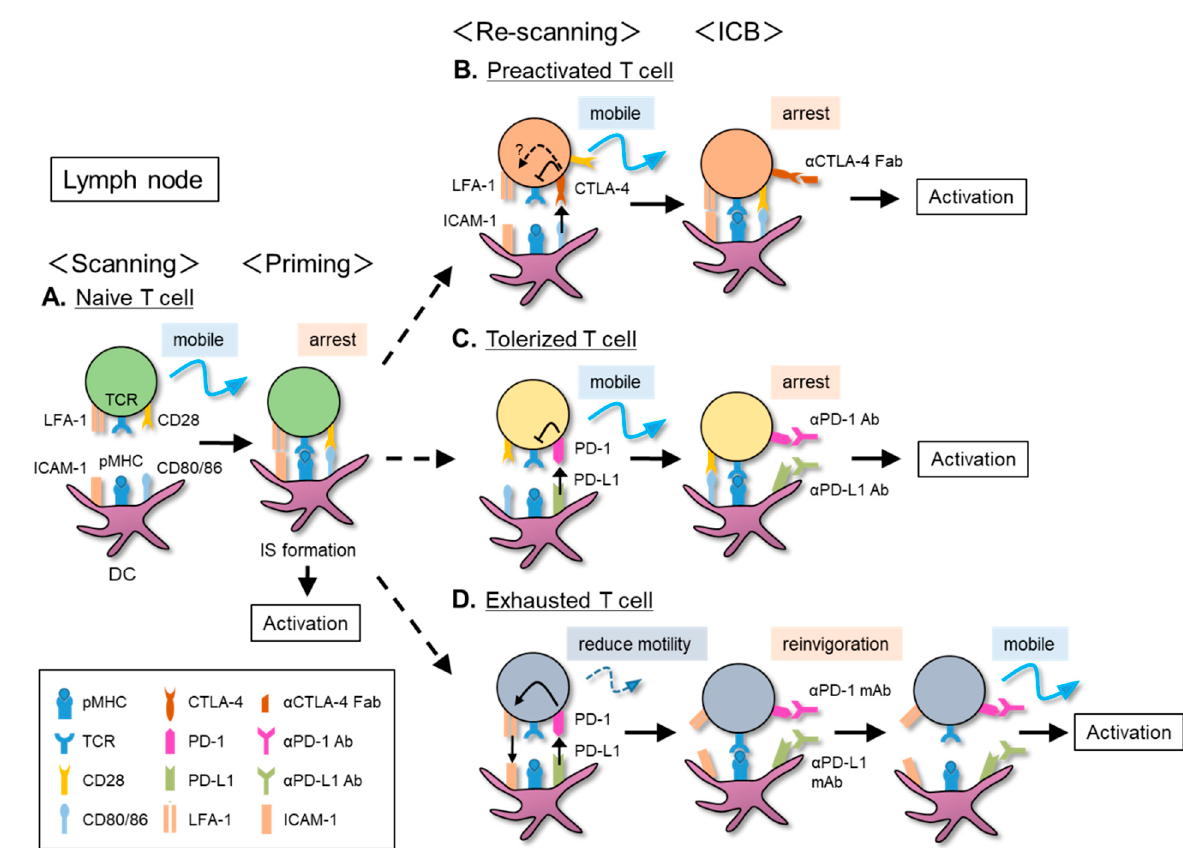
Figure 2. Schematic representation of the mobile/arrest-switching T cells during antigen recognition on dendritic cells (DCs), and the influence of immune checkpoint blockades (ICBs) in lymph nodes (LNs). ( A ) Naive T cells migrating in the paracortical T zone scan for antigen-presenting DCs. T cells that encounter cognate antigens are arrested on DCs and form the IS, composed of TCR–pMHC, costimulatory receptor-ligands, and adhesion molecules, which eventually activate T cells. ( B ) CTLA-4 expressed on preactivated T cells deprives CD28 of CD80/86-binding and inhibits the stop signal. Suppression of TCR-mediated stop signals weakens interaction with DC and retains T cell migration. Blockade of CTLA-4 ligation restores the ability of IS formation, leading to T cell activation. ( C ) In a tolerance-inducing type I diabetes model, PD-1/PD-L1 ligation maintains a tolerized and highly motile state in T cells by inhibiting the stop signal. PD-1/PD-L1 blockade promotes T–DC interaction restoring the ability of T cell arrest, which abolishes tolerance. As CTLA-4 is involved in the formation, but not the maintenance, of tolerance, CTLA ‐ 4 blockade does not alter T cell motility as well as tolerance. ( D ) In a model of chronic viral infection, persistent antigen exposure leads to T cell exhaustion. PD ‐ 1/PD ‐ L1 ligation in exhausted T cells induces clustering of adhesion molecules, causing motility reduction. PD ‐ 1/PD ‐ L1 blockade inhibits adhesion molecule clustering and restores T cell motility. PD ‐ 1/PD ‐ L1 blockade also disrupts inhibitory signals, resulting in the reinvigoration of antiviral responses.